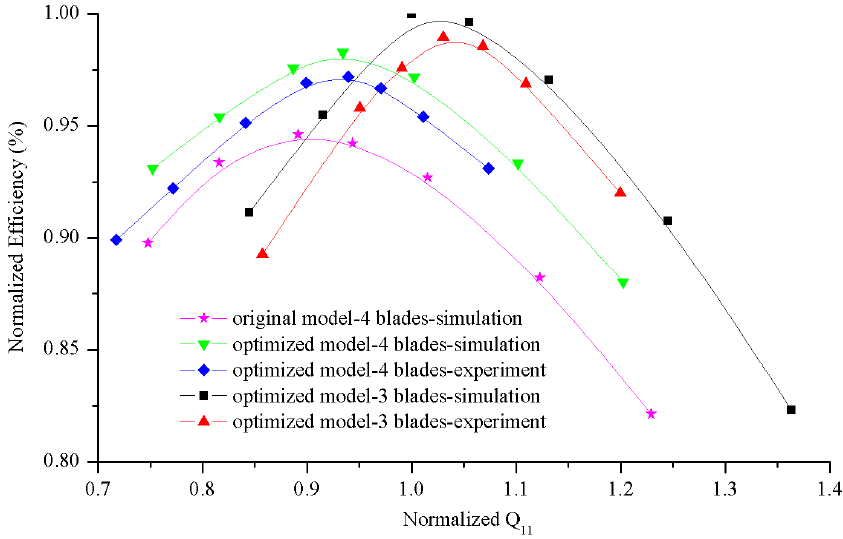
Figure 10. Normalized efficiency vs. normalized Q 11 for the flood turbine mode.